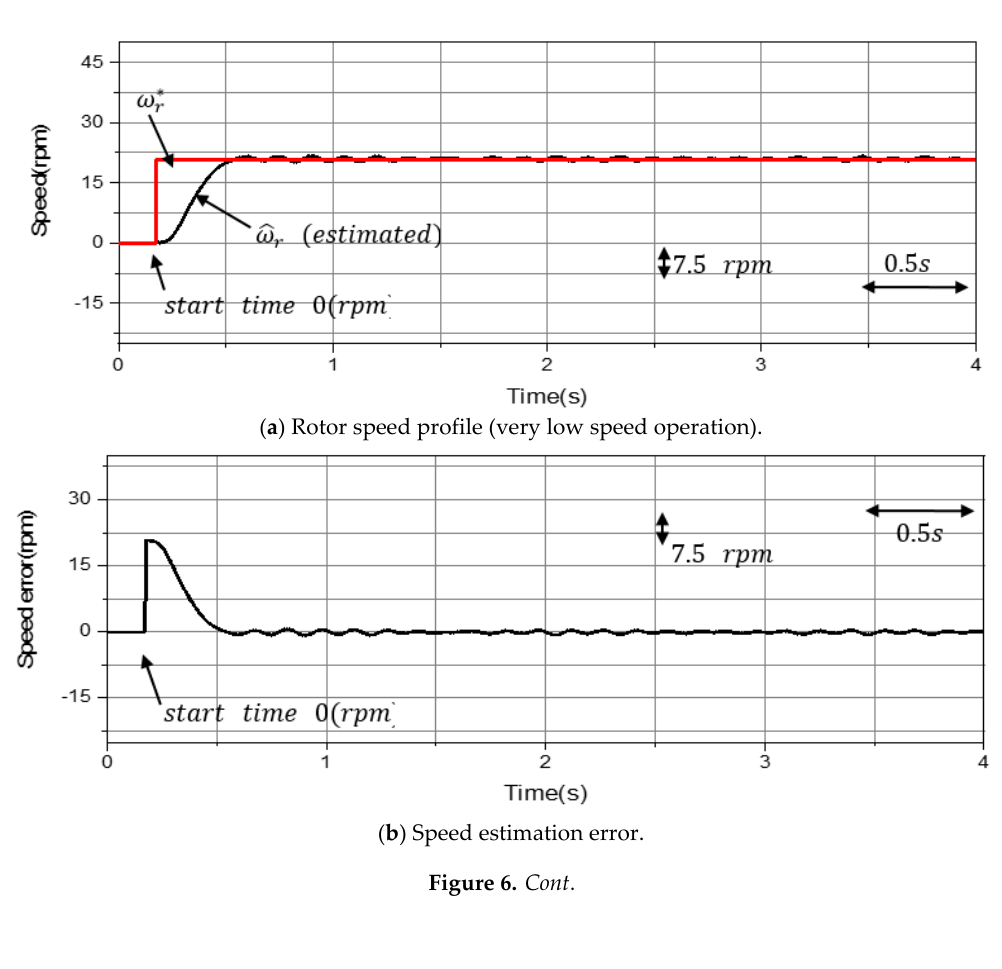
( d ) (x-y) current components, speed, d - current component and q - current component at 50% load Figure 5. Experimental validation at operating speed of 250RPM